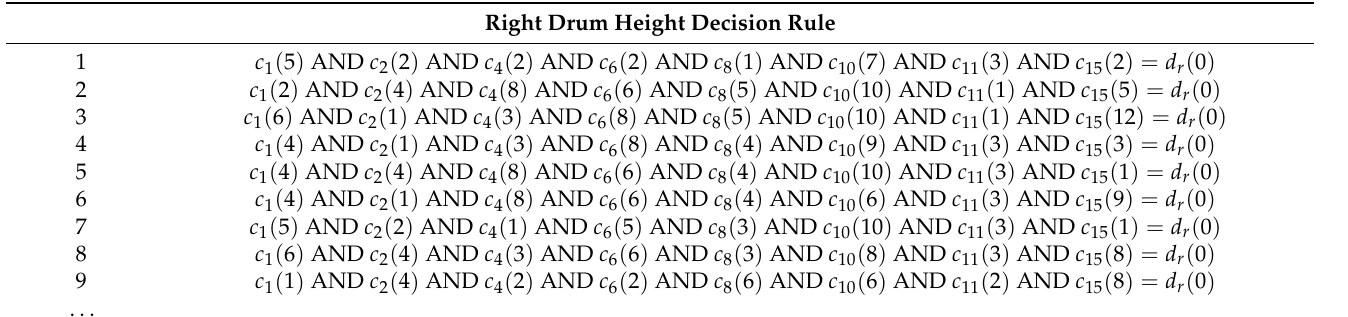
Table 8. Right drum height decision table. Right Drum Height Decision